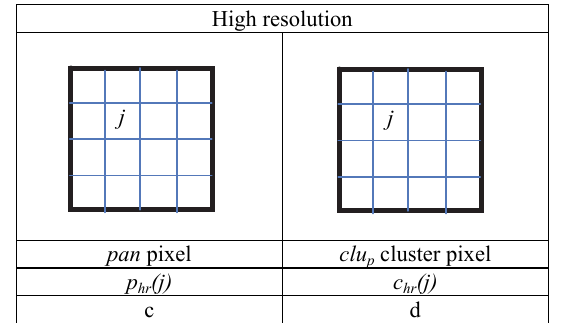
Table 3. Definition and notation of input, intermediate and output pixels of pan-sharpening: (a) panchromatic pixel in high resolution, (b) cluster pixel of pan (index j is used for high resolution pixels in the area occupied by ms pixel i